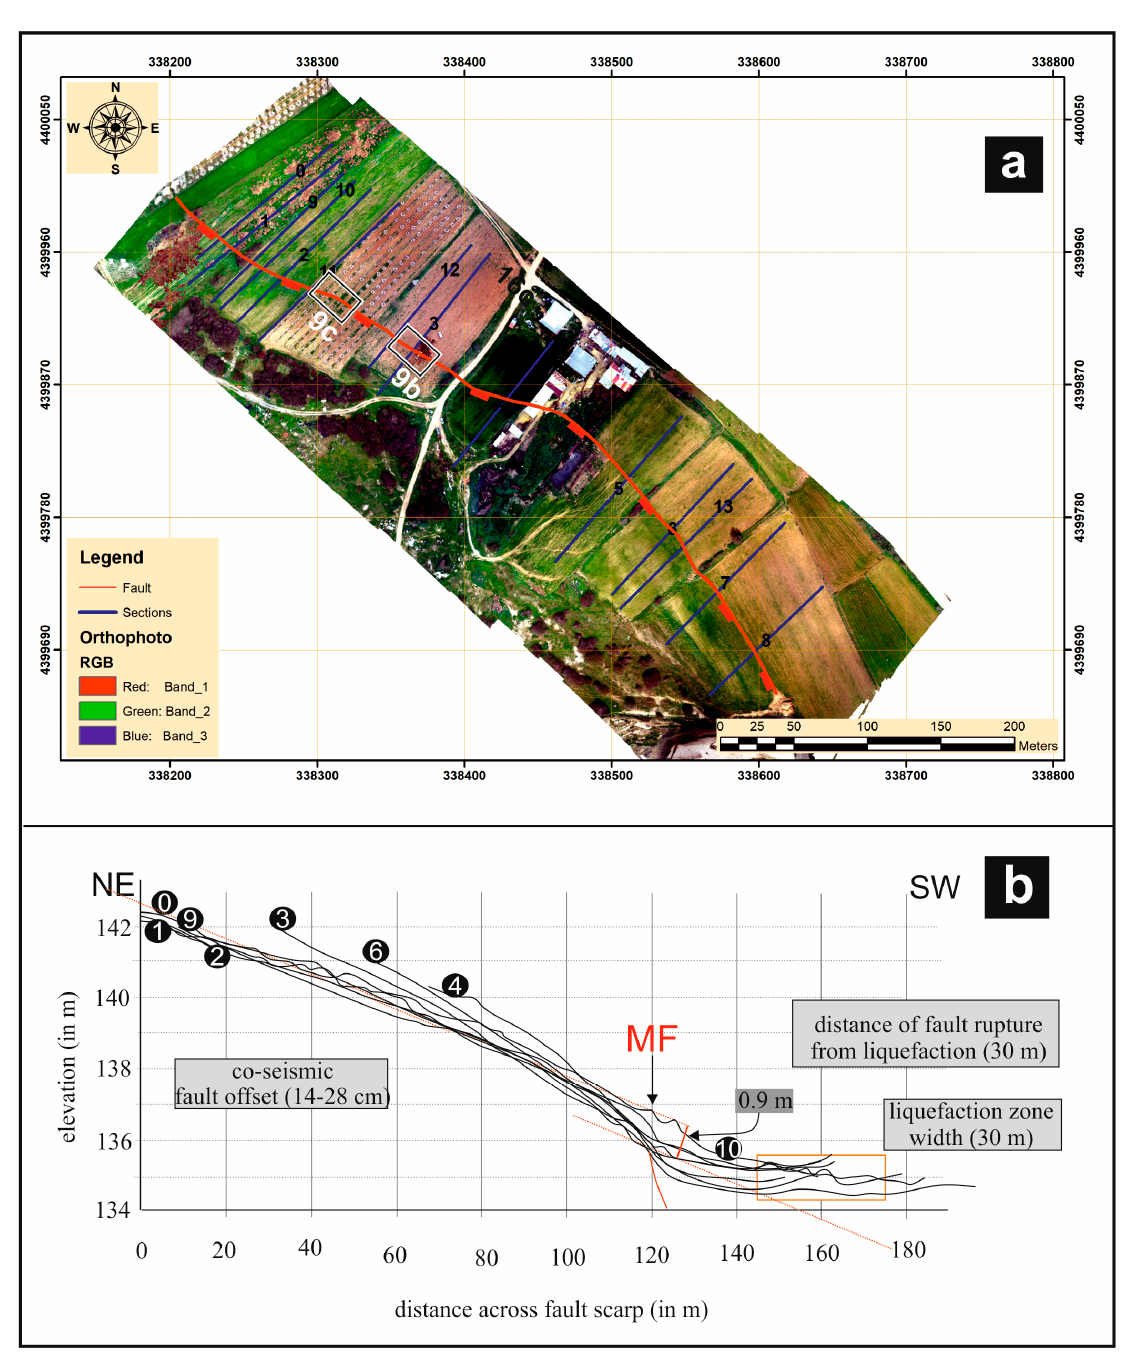
Figure 10. ( a ) Orthomosaic showing location of 13 profiles across the Mesochori (MF) scarp. Red line shows coseismic rupture. ( b ) Fault scarp topographic profiles across MF rupture. Considering its parallelism and its proximity (less than 2 km) with the Vlachogianni Fault and its antithetic behavior, the MF represents a secondary tectonic structure, likely with an accommodation role relative to the north-dipping